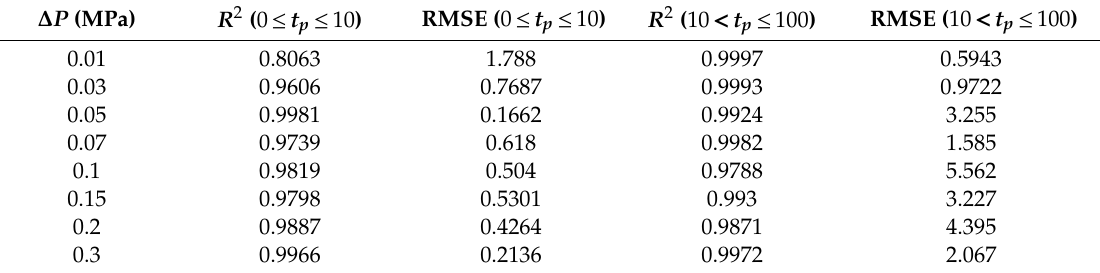
Figure 11. Final polynomial fitting of the volume flow feature: ( a ) 3-D relationship between pressure difference, duty cycle, and volume flow; ( b ) 2-D relationship between duty cycle and volume flow; ( c ) Method for calculating the output duty cycle.